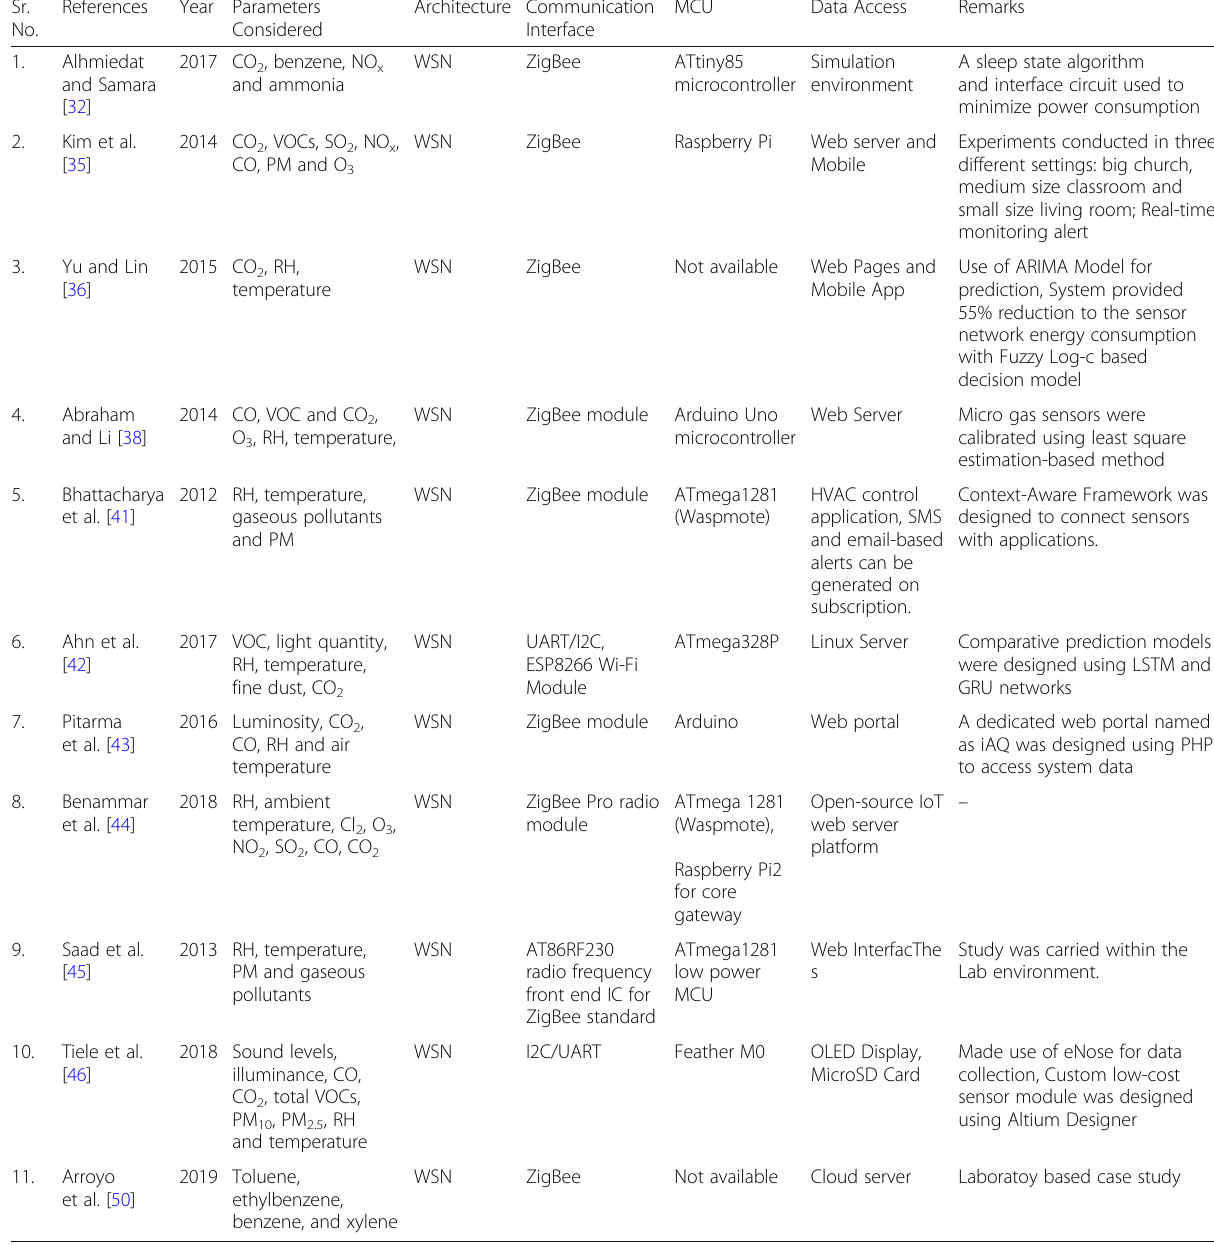
Table 2 Summary of IAQ monitoring systems based on WSN Sr. No.